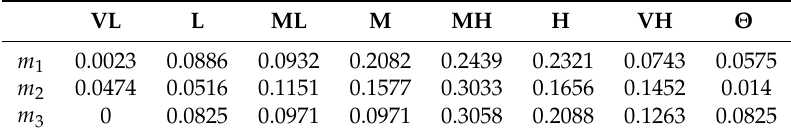
Table 11. The BPAs of bottom criteria after combination in [25].